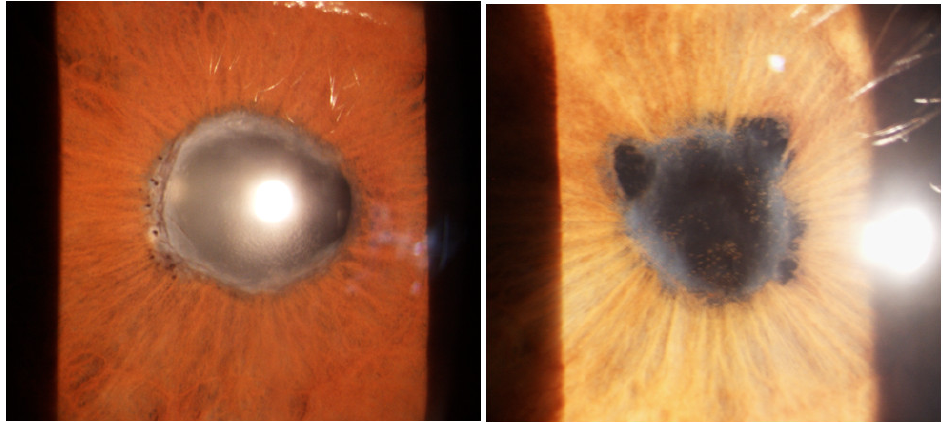
◦ posterior synechiae in Figure 5. Different presentations of 360° posterior synechiae in OS. Figure 5. Different presentations of 360 Figure 5. Different presentations of 360° posterior synechiae in OS.